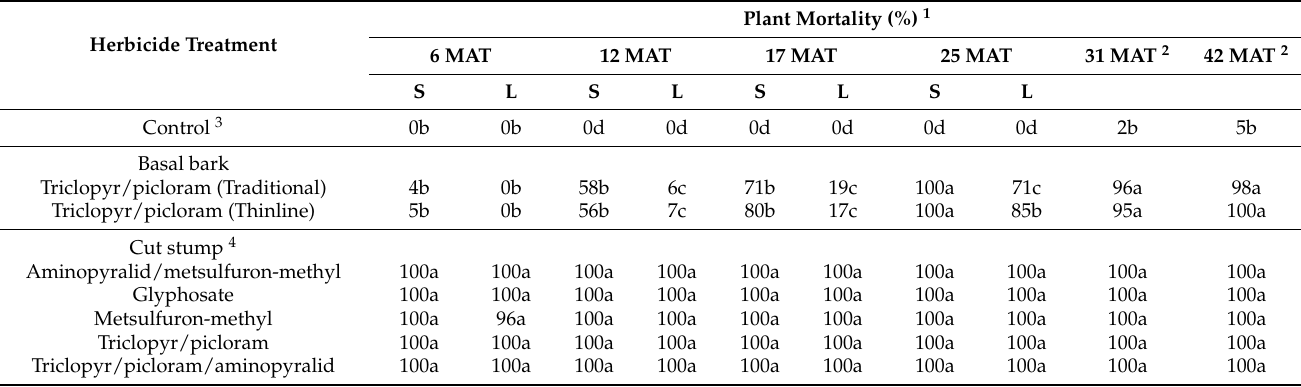
Table 3. Mortality of small (S) and large (L) C. uruguayanus plants 6, 12, 17, 25, 31 and 42 months after treatment (MAT) in response to herbicide treatments applied in May 2016 (Experiment